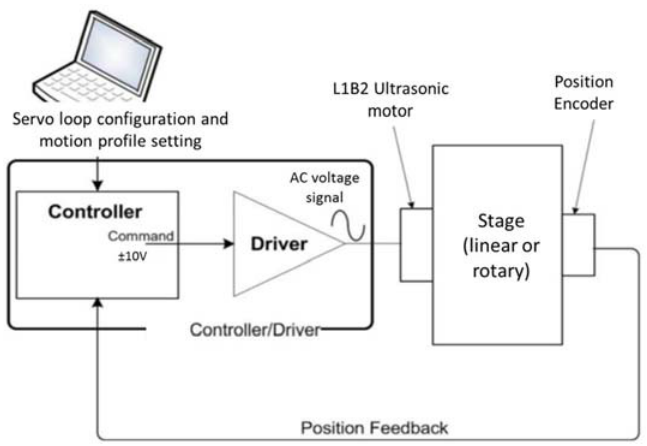
Figure 1. Schematic representation of the architecture of a precise motion solution, based on an L1B2 ultrasonic motor.